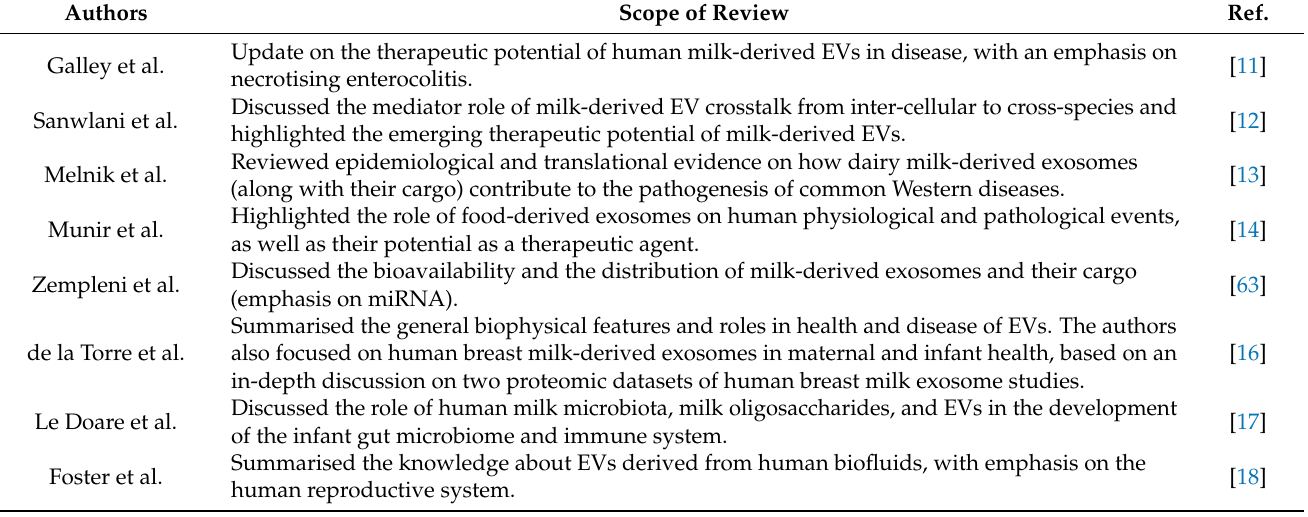
Table 2. Recent review articles of milk-derived